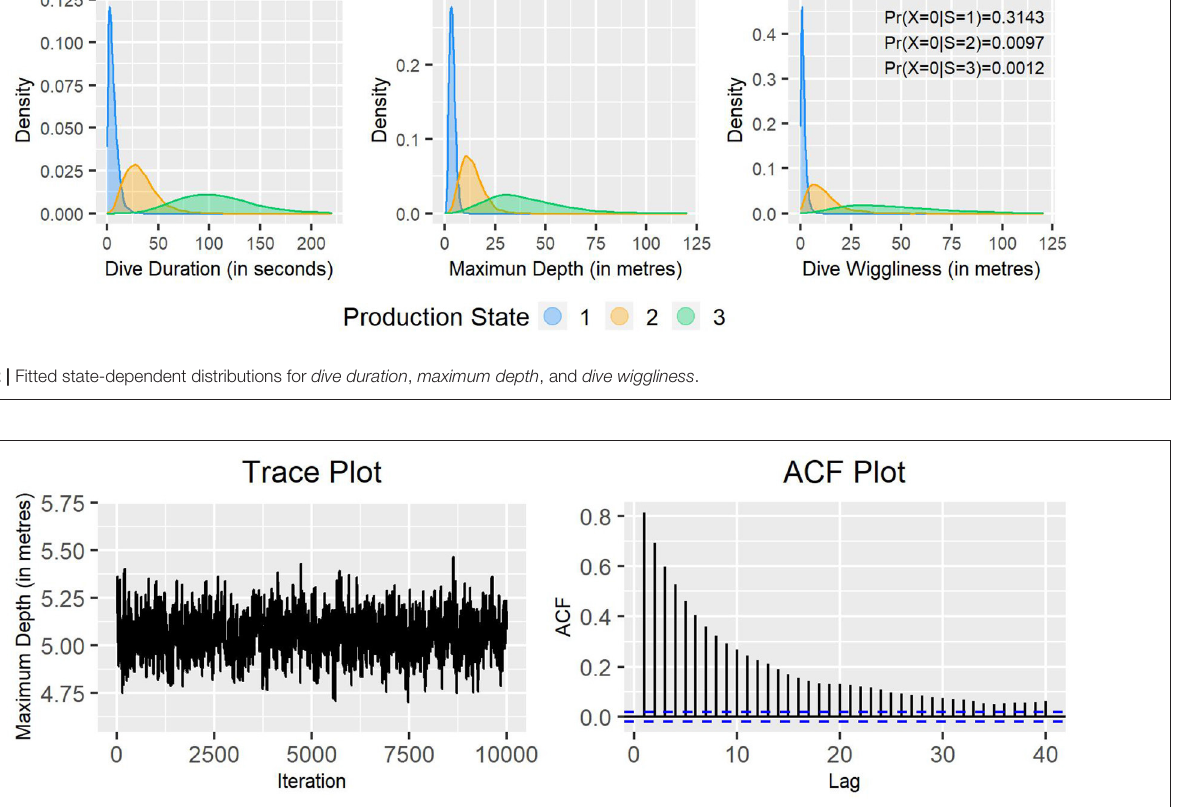
FIGURE 3 | Single-update MH algorithm: trace plot and ACF plot of the standard deviation of the variable maximum depth for production state 2 (10,000 iterations).